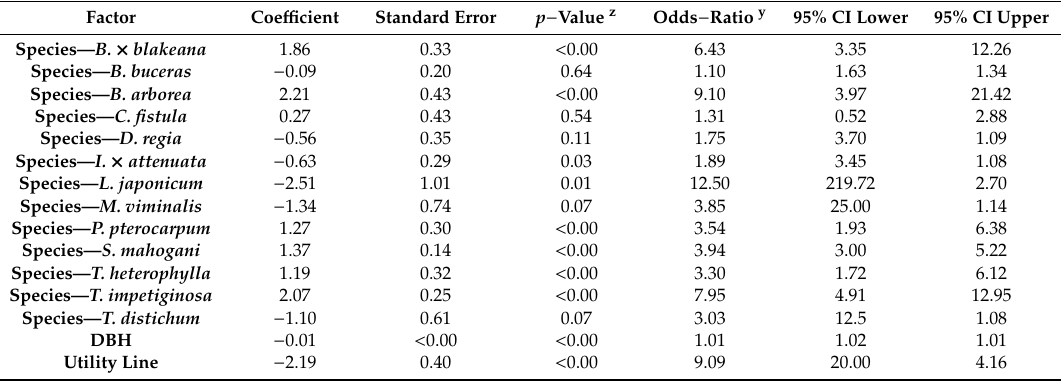
z p -Values for species indicate whether the proportion of individuals in each damage category for a species di ff ered from the baseline species ( Quercus virginiana Mill.). y The odds-ratio indicates the magnitude of the change in likelihood of being in a higher (for positive coe ffi cients) or lower (for negative coe ffi cients) damage category (i) between a species and the baseline species, (ii) for a 1 cm increase in DBH, or (iii) if utility lines were